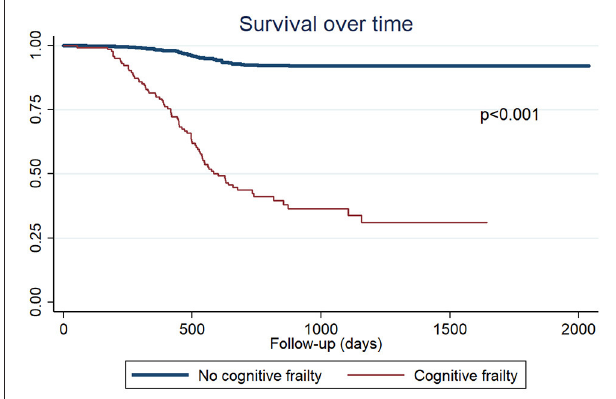
FIGURE 2 | Kaplan-Meier survival curves according to the cognitive frailty